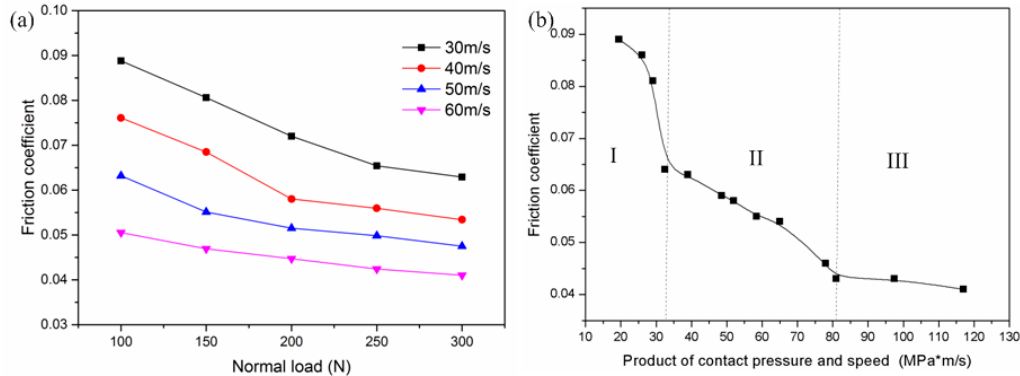
Figure 4. Friction coefficients: ( a ) at various loads vs. ( b ) the product of contact pressure and speed.